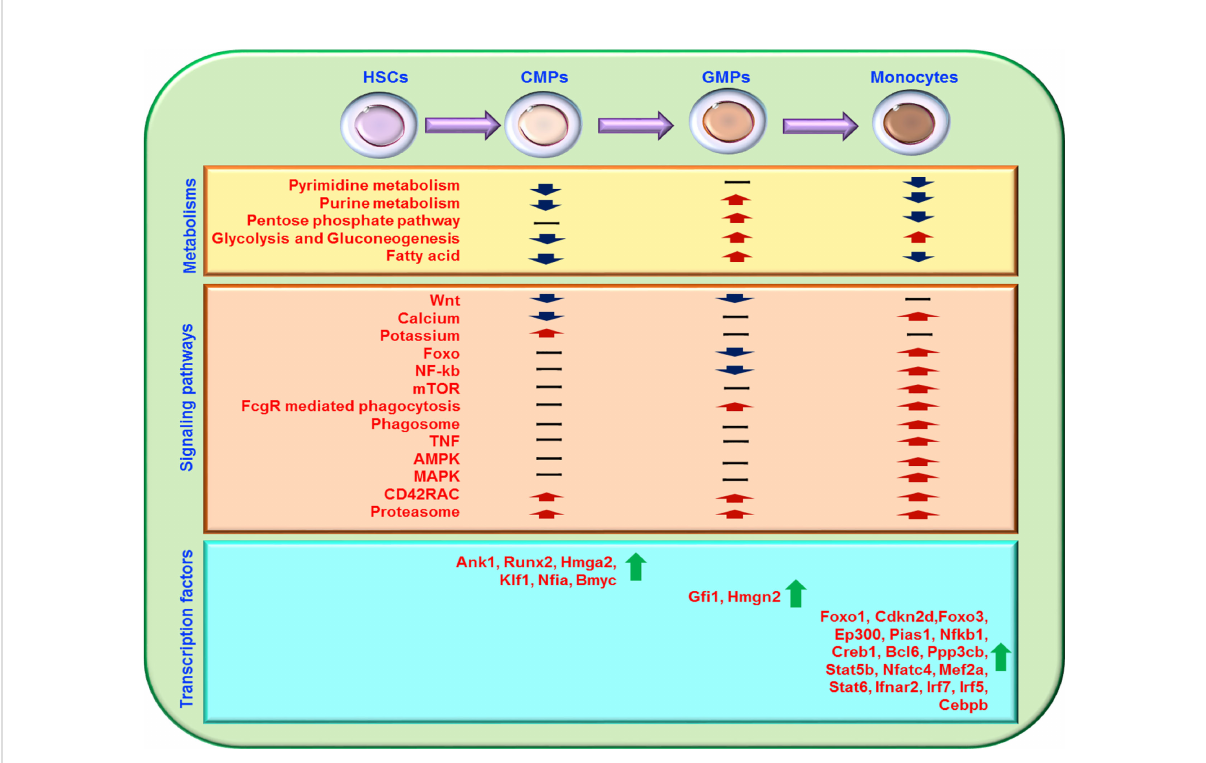
FIGURE 7 Schematic diagram of the major transcriptional regulation during the development of HSCs to monocytes. Most gene transcriptional expressions related to cell metabolisms, signal pathways, and transcription factors during the differentiation of HSCs into monocytes are summarized. “ - ” represents no signi fi cant regulation, “ ↑ ” represents upregulation, and “ ↓ ” represents